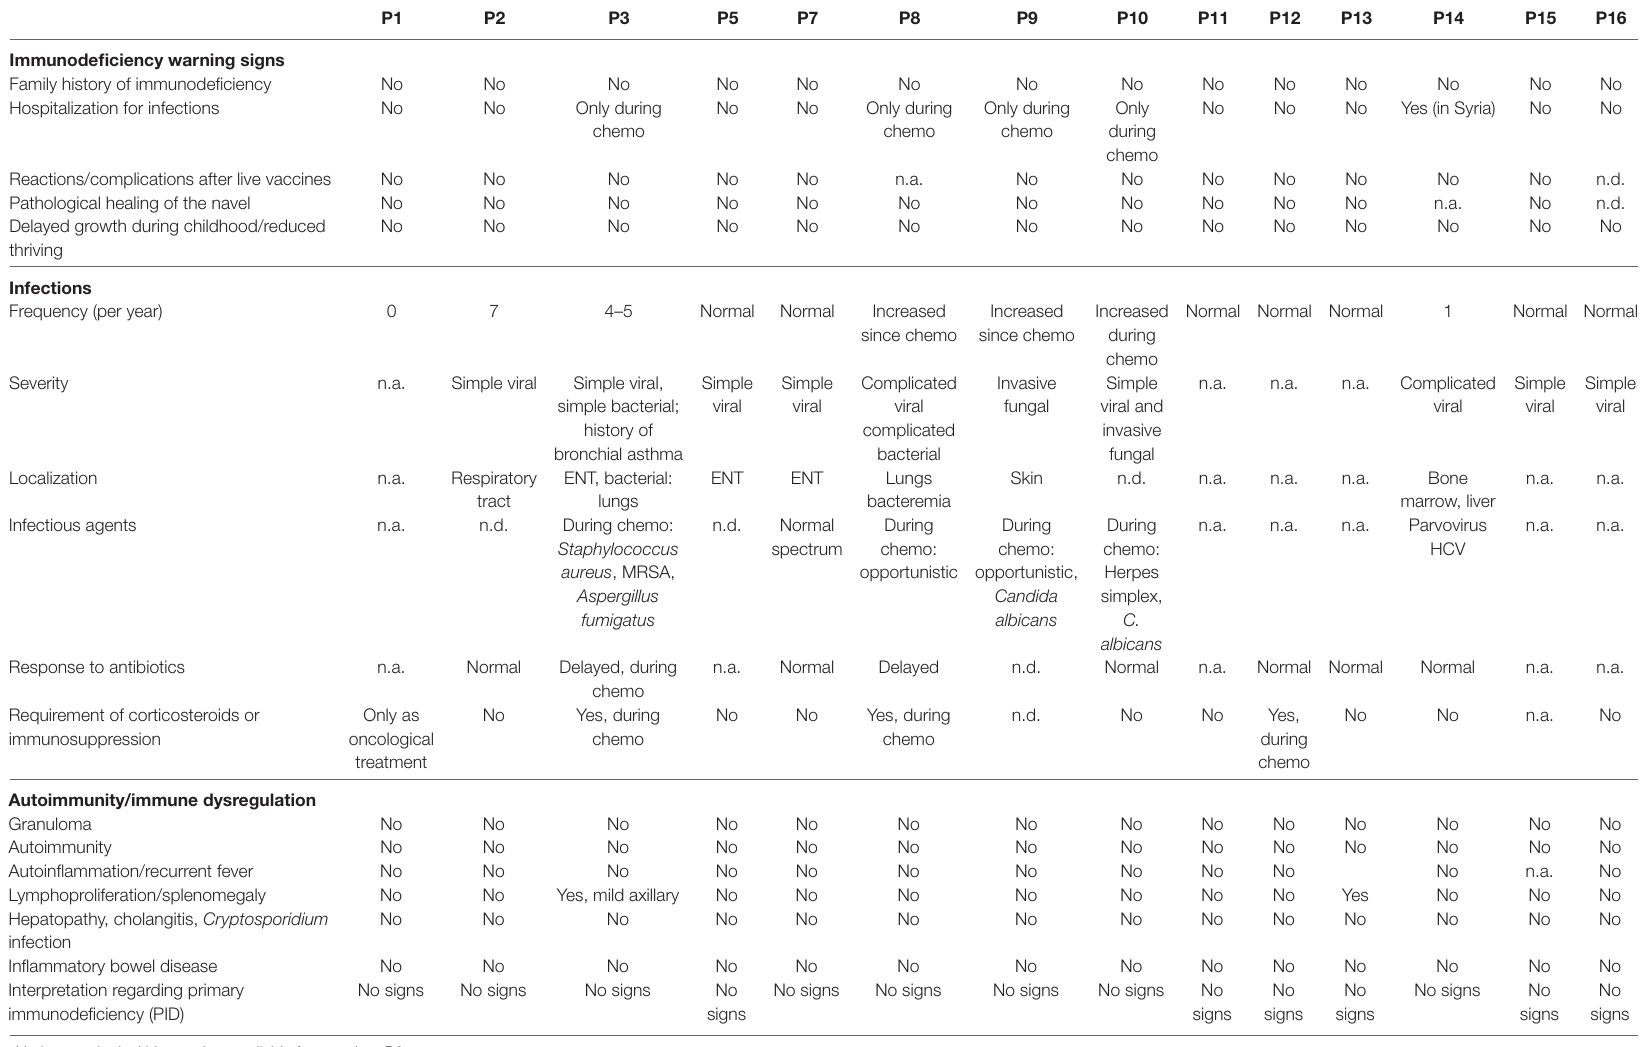
P1 Only during chemo